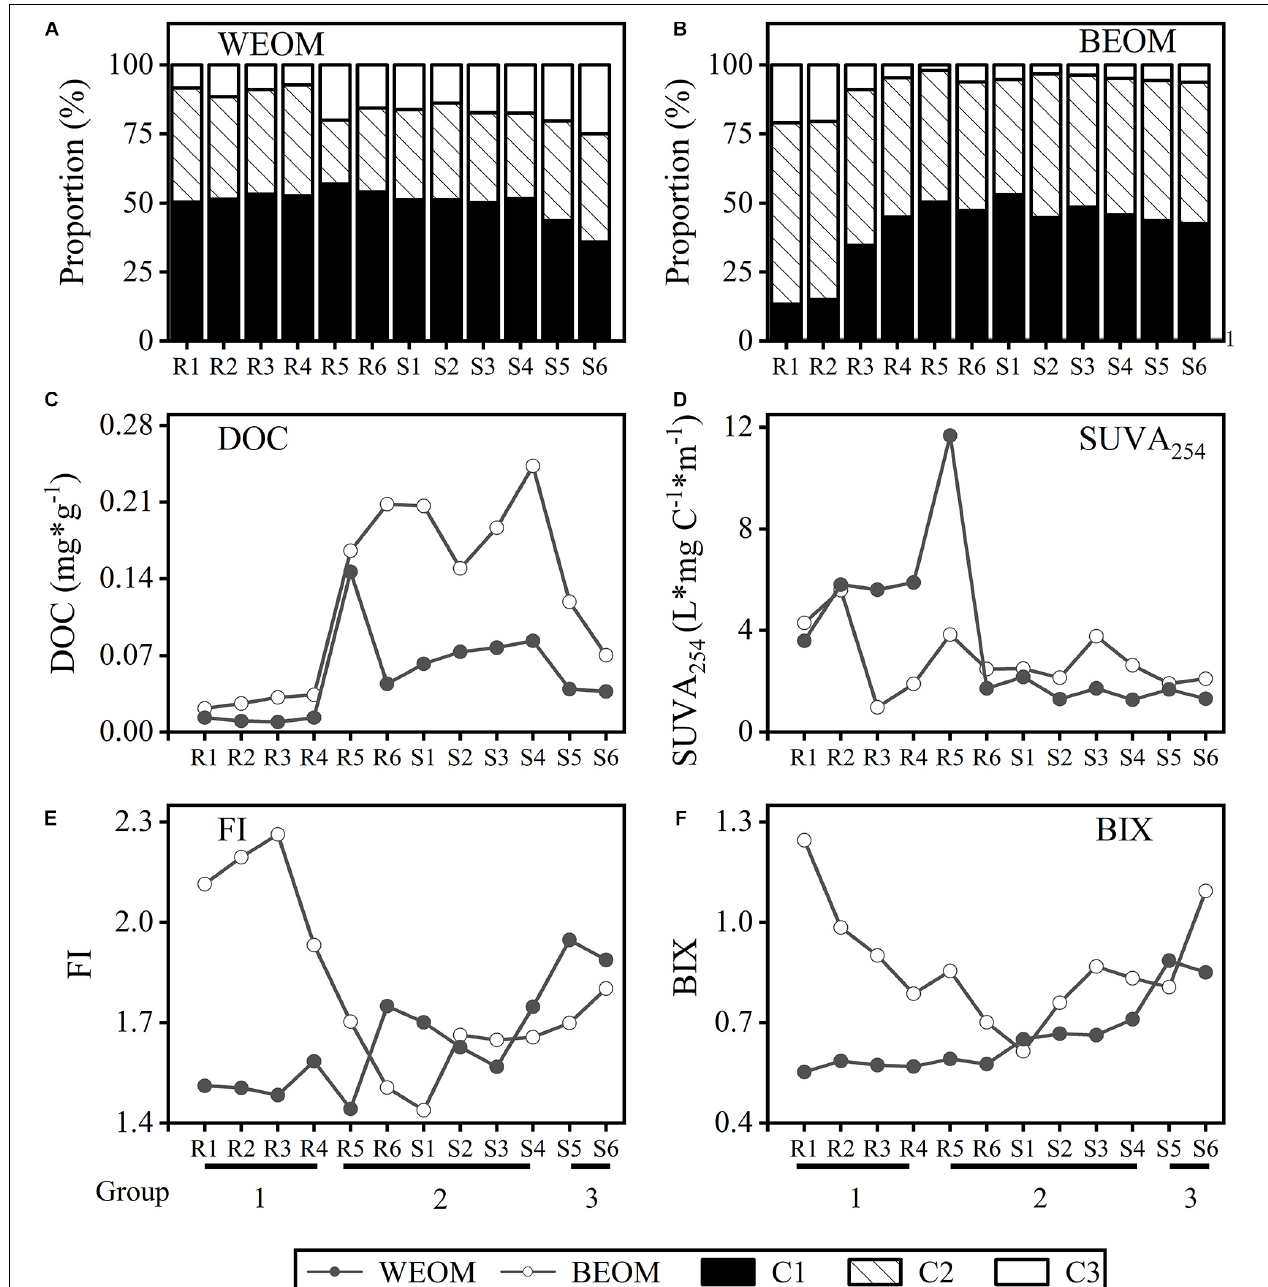
FIGURE 5 | Spatial distributions of dissolved organic carbon (DOC) contents and optical indicators in the water-extractable organic matter (WEOM) and base-extractable organic matter (BEOM). (A) Proportions of C1, C2 and C3 in WEOM; (B) proportions of C1, C2 and C3 in BEOM; (C) dissolved organic carbon (DOC) concentration; (D) SUVA 254 ; (E) FI; and (F)